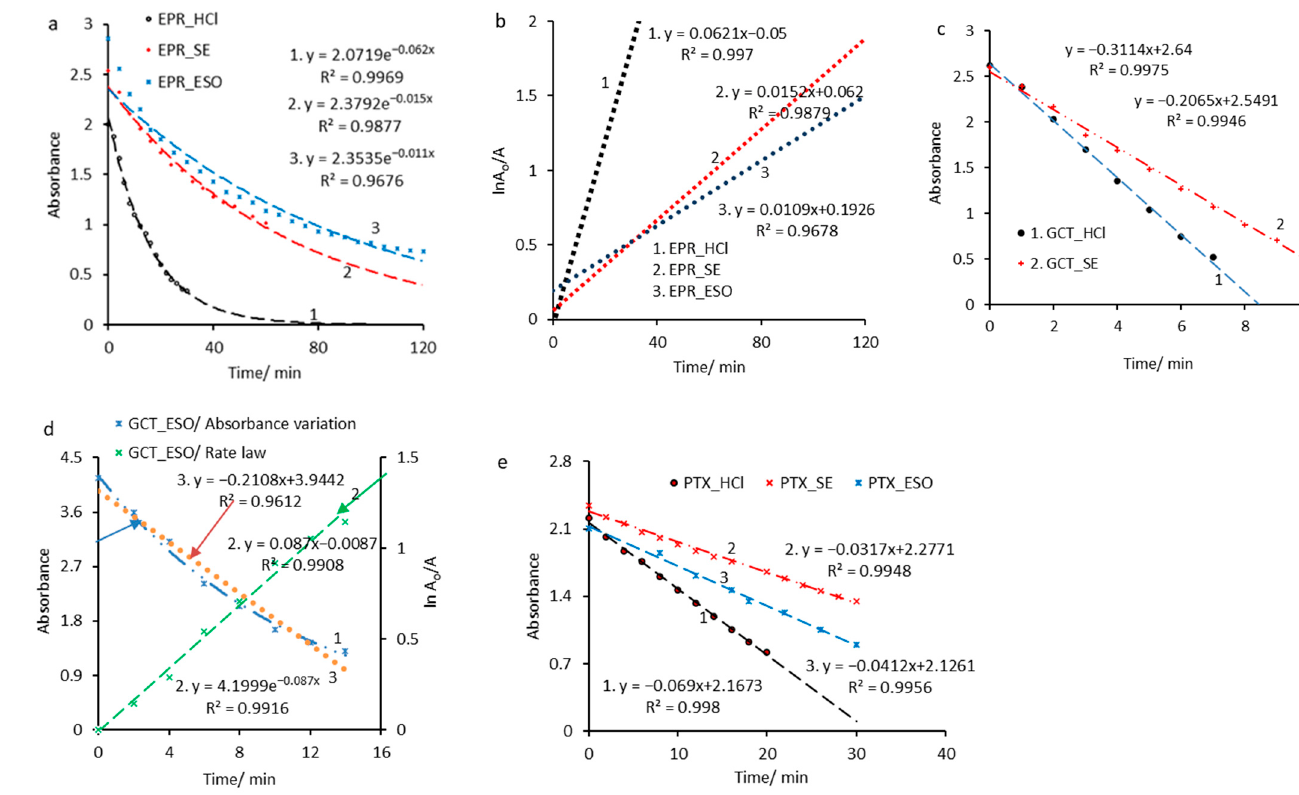
Figure 4. Kinetic model approached for the electrodegradation reaction of chemotherapeutics: ( a , b ) kinetics of first-order reactions applied on the epirubicin decomposition in all studied media; ( c ) kinetics of zero-order reactions applied on gemcitabine decomposition in HCl blank solution and in SE; ( d ) kinetics of first-order reactions applied on gemcitabine decomposition in the essential oil presence (ESO); ( e ) kinetics of zero-order reactions applied on the paclitaxel decomposition in all the three media.